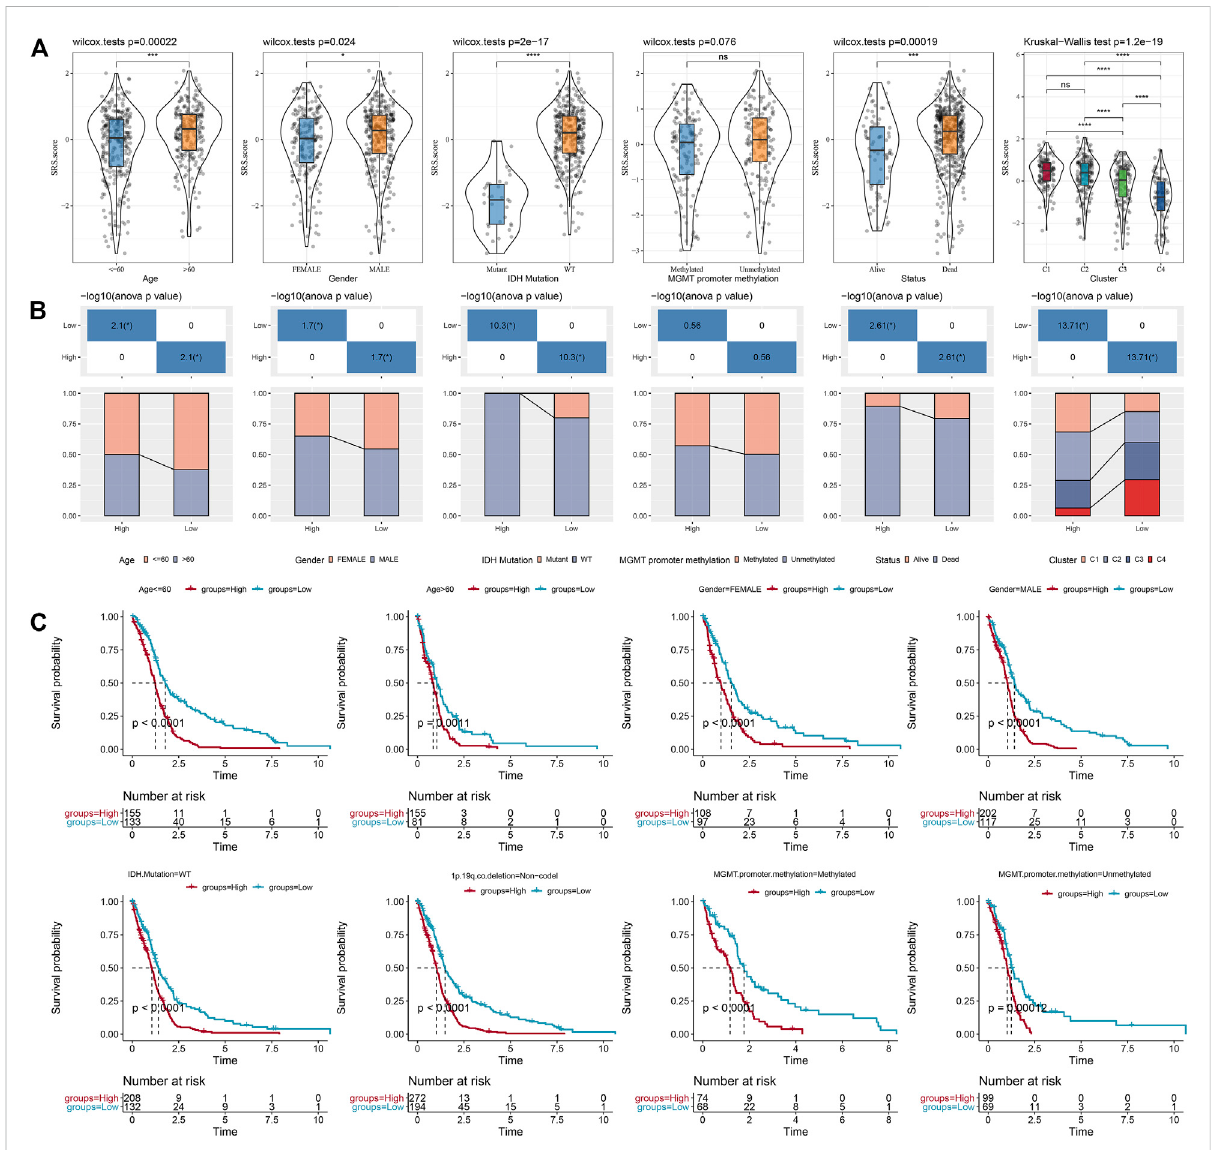
FIGURE 8 Speci fi city of clinical features in the SRS.score subgroups. (A) Differences of SRS.score among different clinical pathological groups in TCGA- GBMcohort; (B) ClinicopathologicalfeaturesbetweenSRS.scoregroupsinTCGA-GBMcohort; (C) KMcurveofSRS.scorebetweenhighandlowrisk groups among different clinical pathological groups in TCGA-GBM